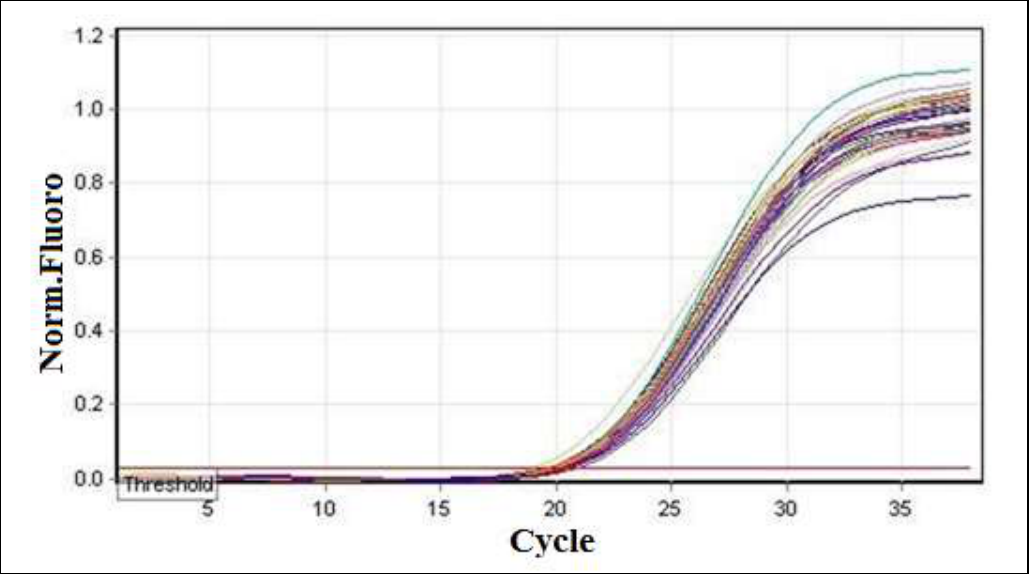
Figure 1: Amplification plots of a miR-122a gene by